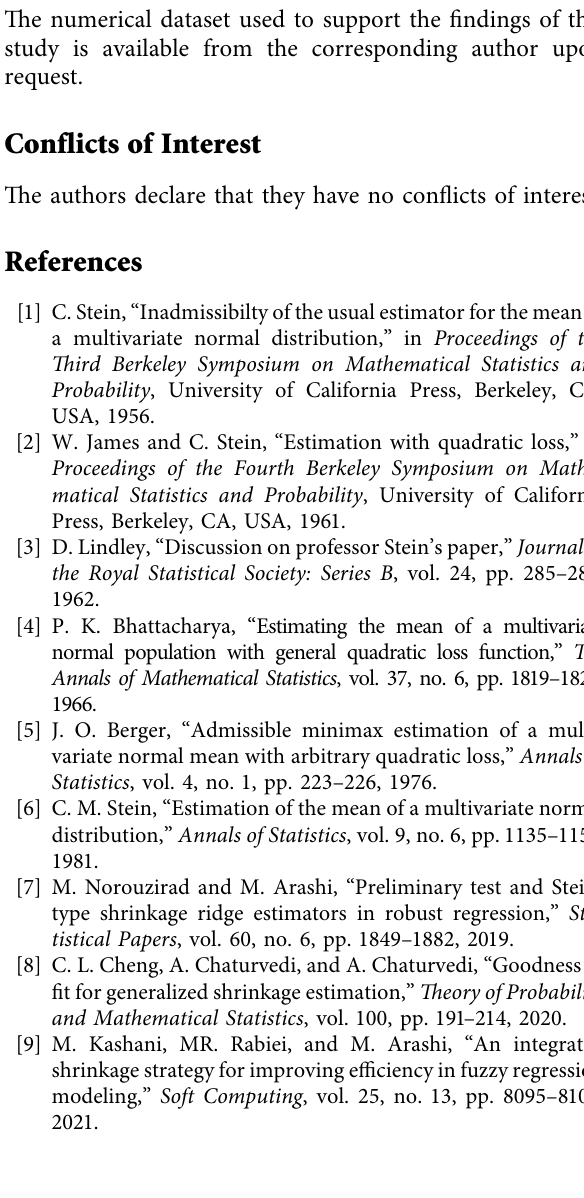
( T ( 4 ) (‖ Y ‖ 2 ) , ] ) / R 􏽢 ω δ ,JS +